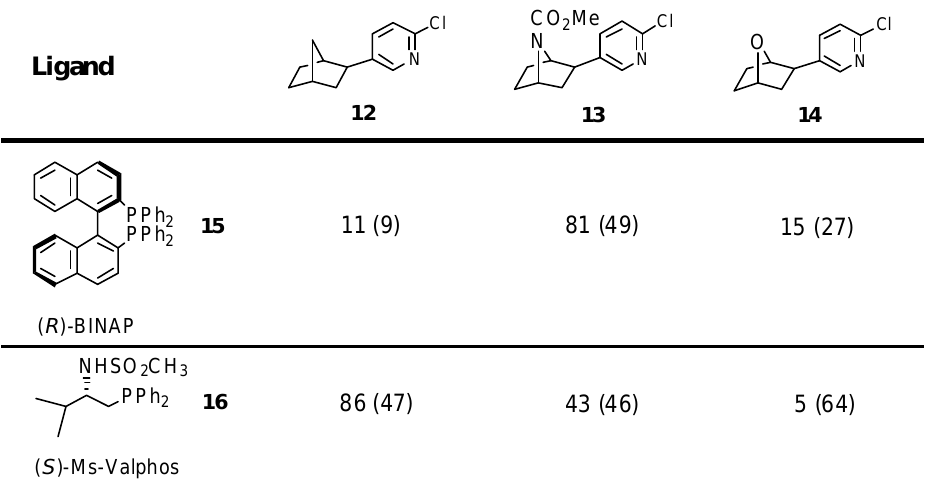
Table 1. Asymmetric hydro(hetero)arylation of bicyclo[2.2.1]heptene and its